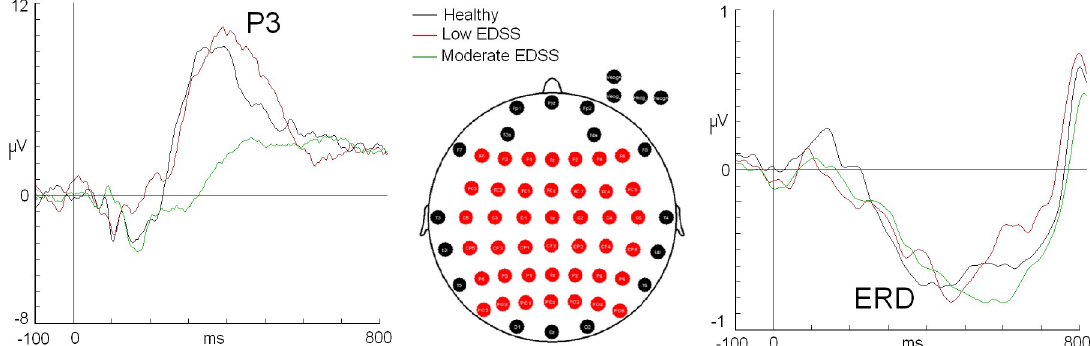
Fig 1. Electrode array and Pzp wave for alpha event-related desynchronization and P3 component. The X axis represents “time” expressed in milliseconds (ms), and the Y axis represents the “amplitude” of the ERP/ERD in microvolts ( μ V). The vertical dashed line indicates the onset of the stimulus. The black trace corresponds to the healthy group: red corresponds to the low-EDSS group, and green corresponds to the moderate-EDSS group. Note the delayed latency in ERD latency for the moderate-EDSS group compared to healthy control